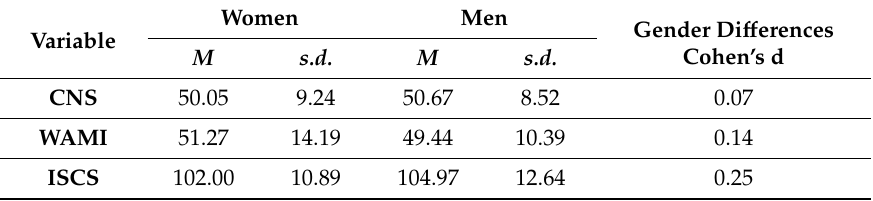
Table 3. Gender di ff erences among selected variables for mediation